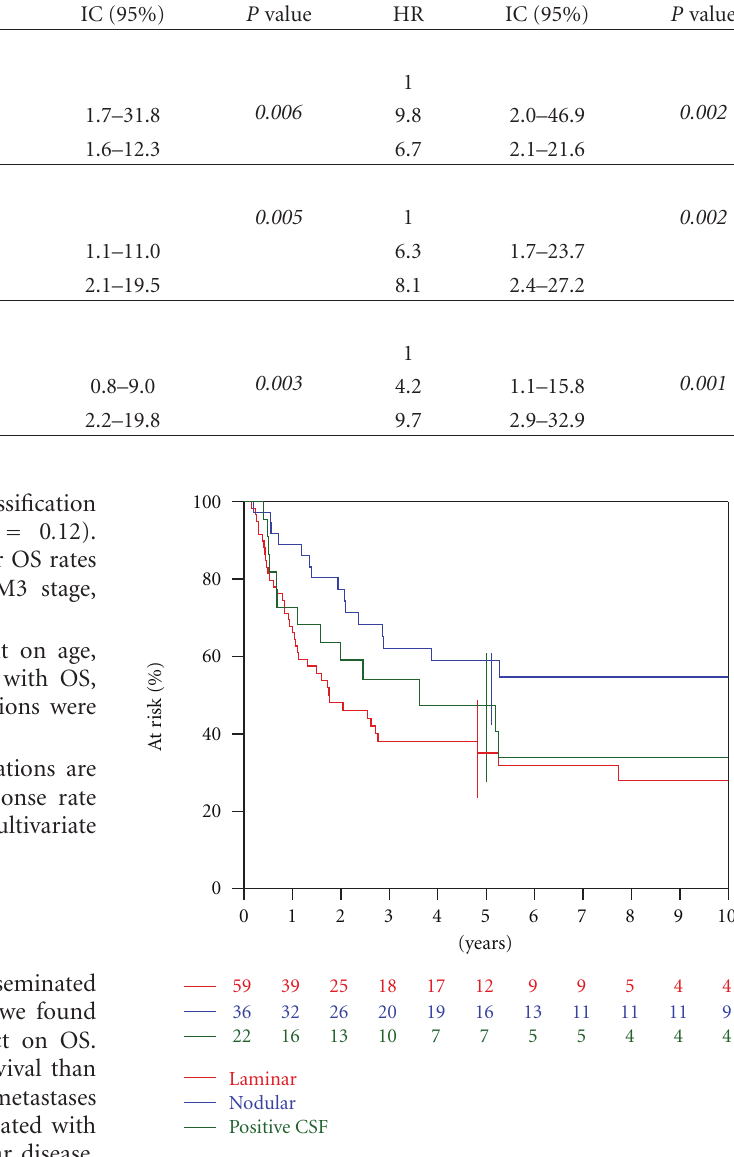
Figure 3: Overall survival according to qualitative